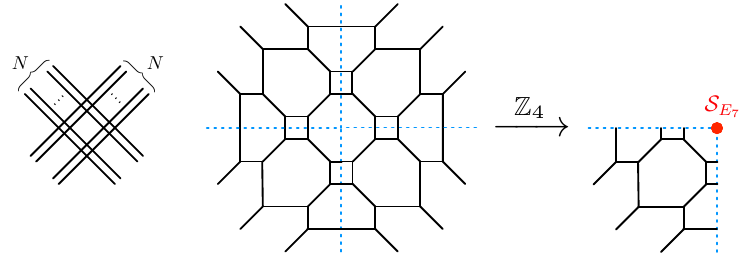
Figure 16 . 5d X N,N -theory and the Z 4 quotient of the X 3 , 3